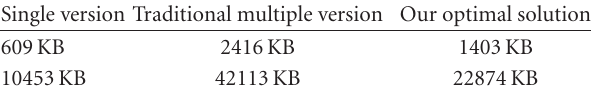
Table 4: Amount of memory used by di ff erent systems for di ff erent versioned files.